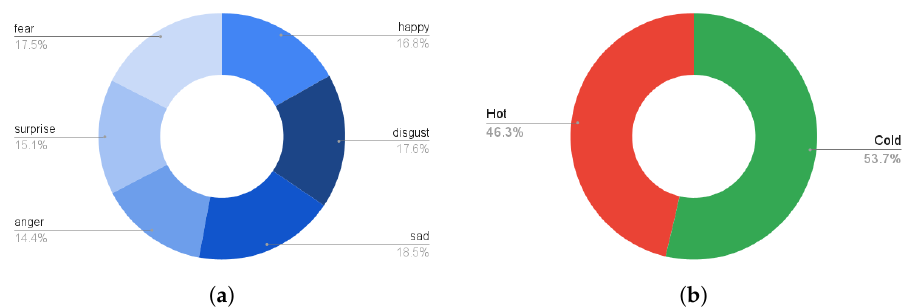
Figure 1. Class distribution for emotions dataset used in this study is shown. ( a ) class distribution of six basic emotions; ( b ) class distribution of hot and cold